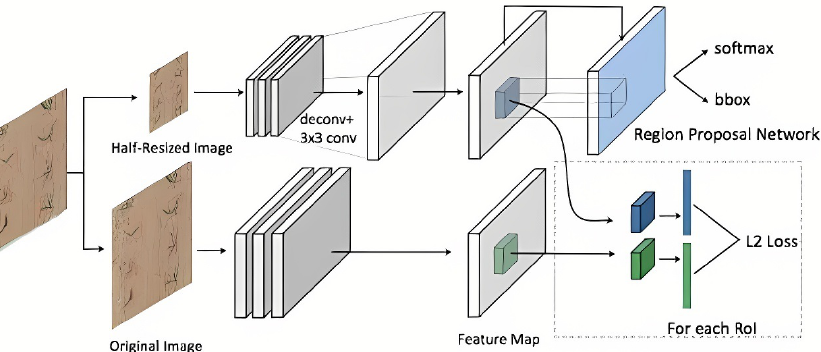
2Figure 2. The architecture of maize seedling detection model, as applied to the estimation of seedling count and seedling Figure